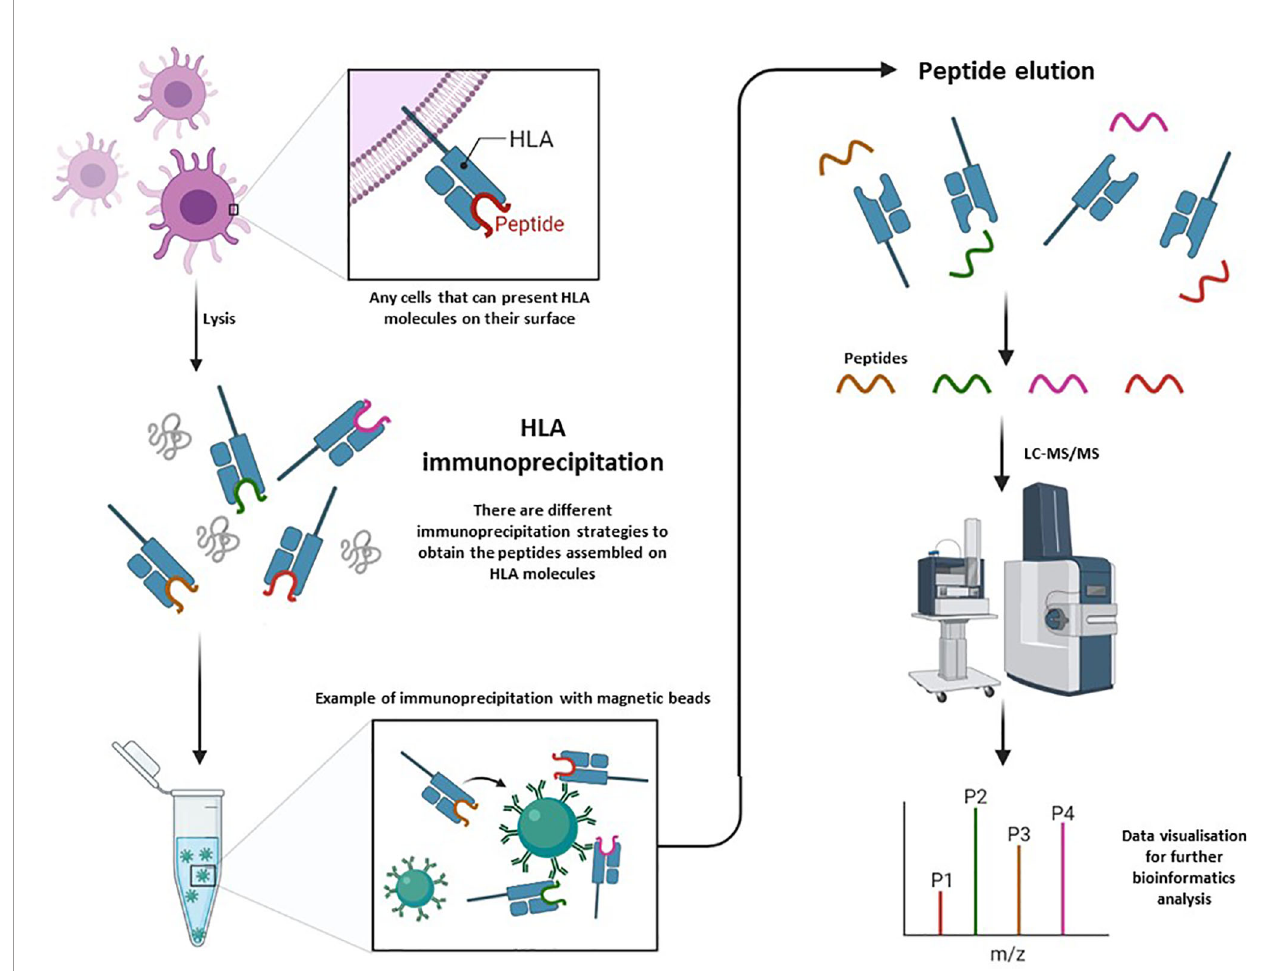
FIGURE 2 | Global overview of the work fl ow for speci fi c isolation of peptides from HLA molecules by immunochromatography and their further systematic characterization by